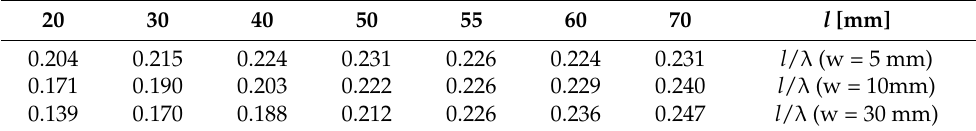
Figure 11. Dependence of resonant frequencies of flat microwave antennas on their length showing the significant crossover point S . Table 3. Resonance point values l / λ res of flat microwave